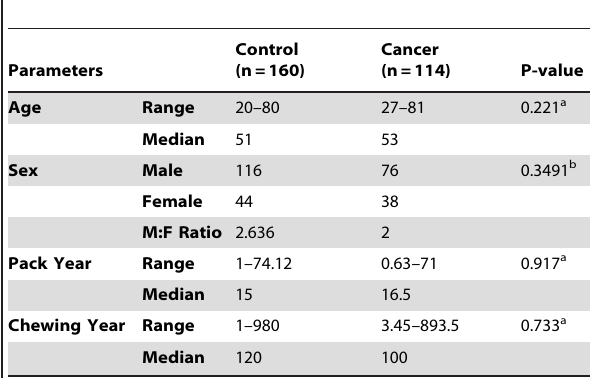
Table 3 provides P-values for different association tests such as: (a) without any adjustment of covariates [age, sex and tobacco Table 2. Basic characteristics of cancer and control in replication